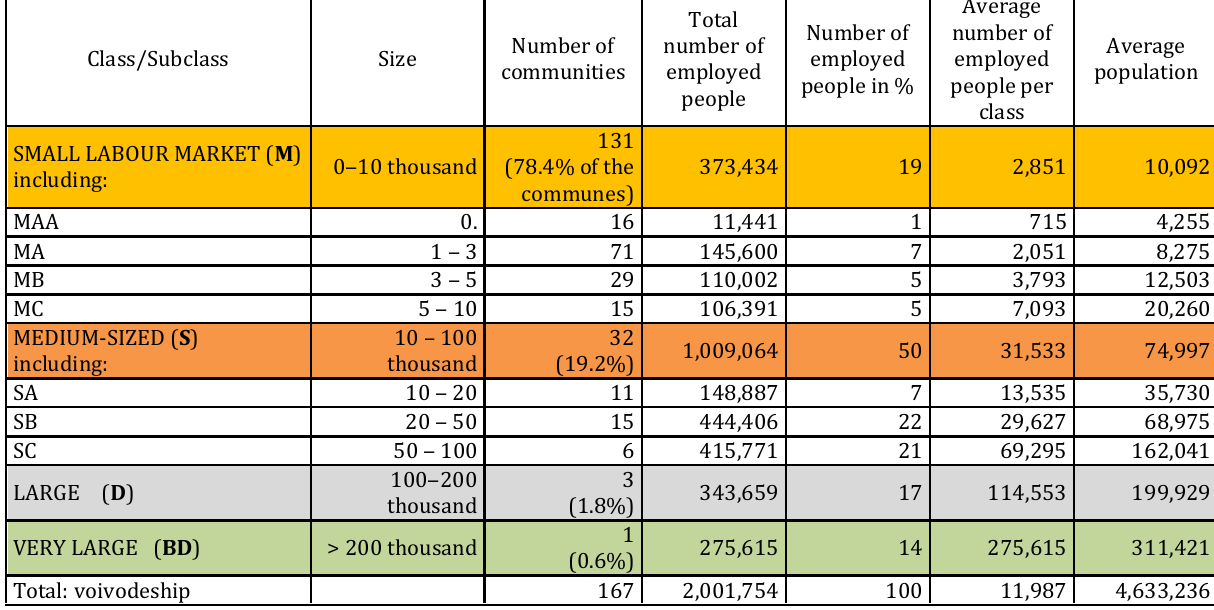
Table 1. Selected data on labour markets in the Silesian voivodeship in 2010 according to size classes (after Sitek et al., 2013) Class/Subclass Size